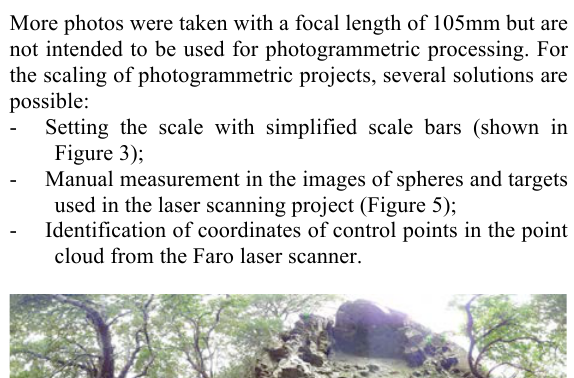
Figure 6. Coloured point cloud of the Grotta Scritta 1 (front